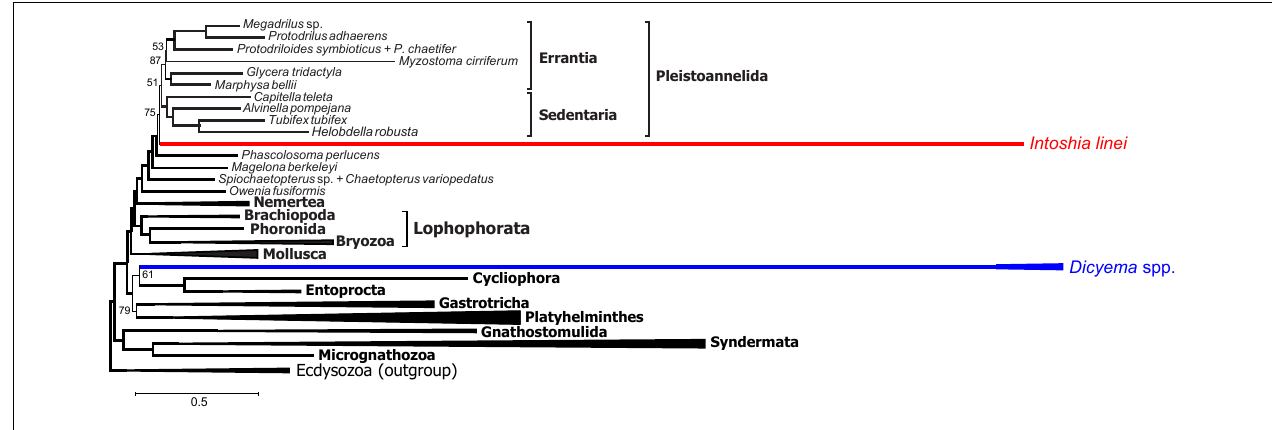
FIGURE 12 | PhyloBayes topology for proteins with the strong annelid signal (concatenate of 111 protein alignments that possess at least 3% positions with q > 1 / 2 , 18686 alignment positions in total, CAT + GTR + (cid:48) 4 model, 50,000 chain steps, 50% burn-in). Only posterior probability values less than 0.95 are shown. Convergence value of maxdiff =